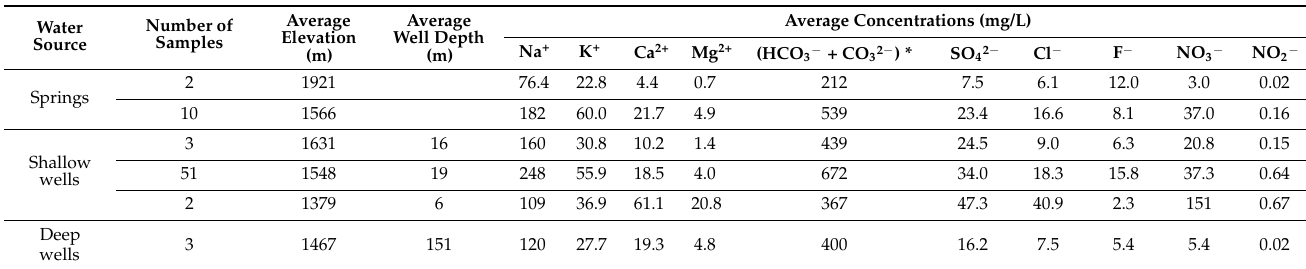
Table 7. Average values of major and minor ions in the water samples from different elevations on the southwestern flank (* as mg/L HCO 3 − ).